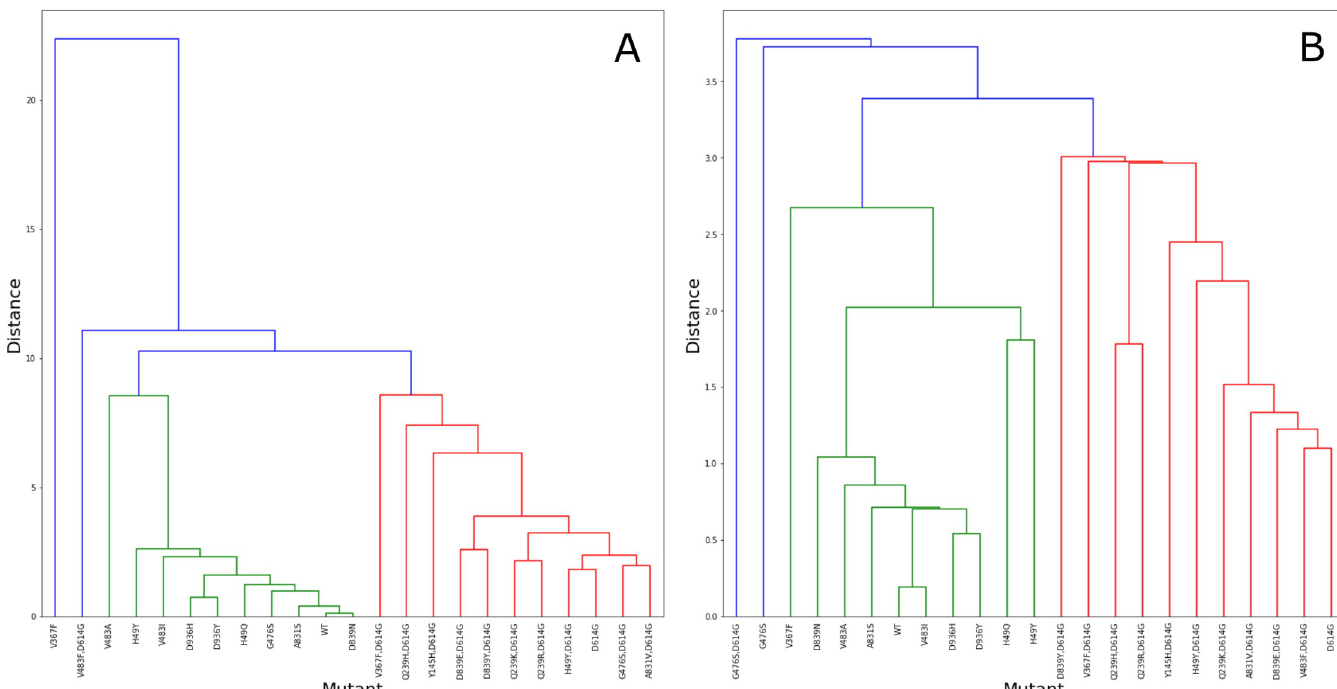
Fig 3. Dynamical Signature clustering for the closed (A) and open (B) state structures for WT and 22 mutants from GISAID (S1 Table). The clustering measures the distance between each pair of Dynamical Signature. Different colors were used to identify branches within a threshold of similarity (8.7 and 3.2 for closed and open state, respectively). The branches that comprehend most strains containing the D614G mutation are highlighted in